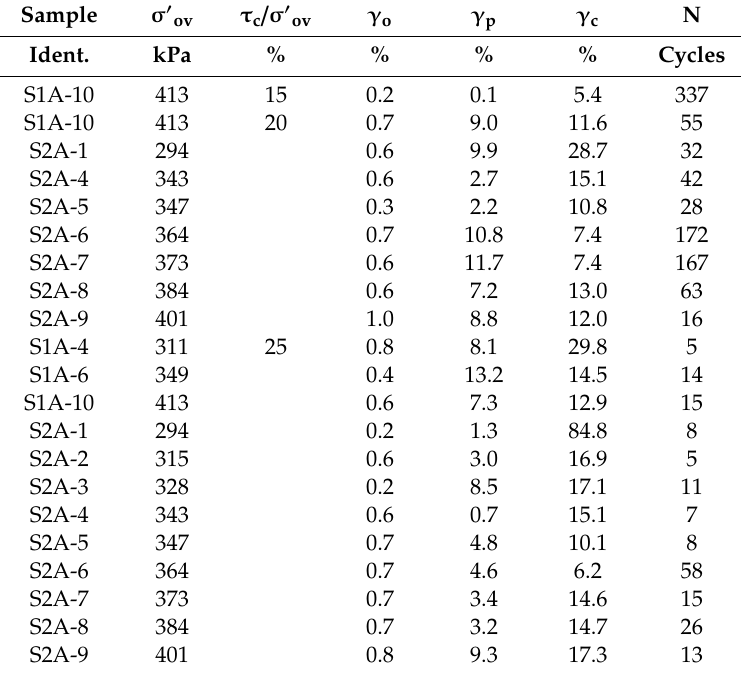
Table 5. Results of cyclic simple shear test with τ o / σ (cid:48) ov = 5%.